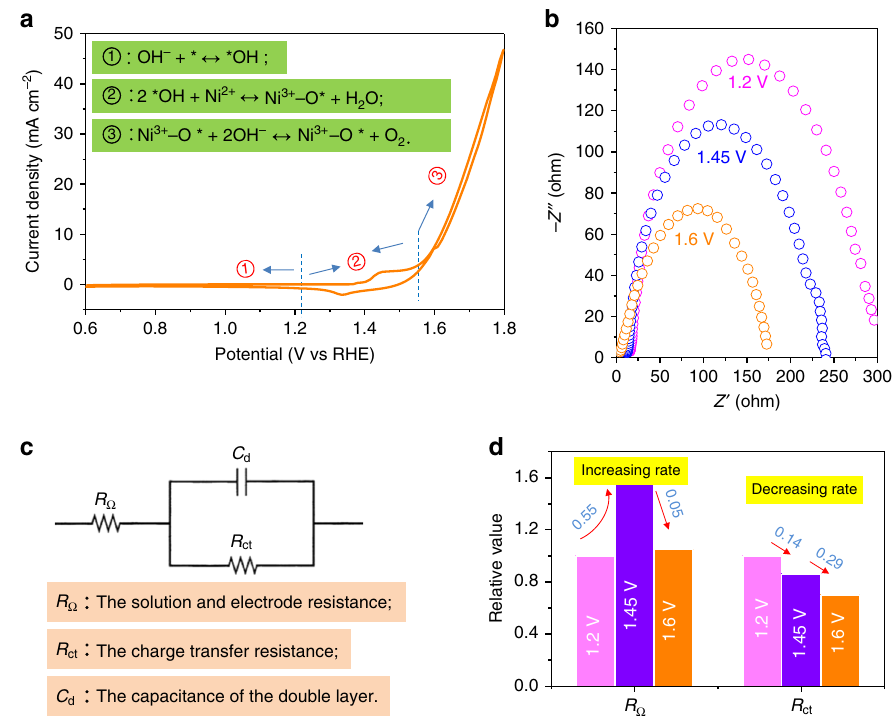
Fig. 1 Electrochemical analysis of Ni(OH) 2 for OER processes. a Cyclic voltammetry (CV) for Ni(OH) 2 at the potential range of 0.6 – 1.8 V; b Nyquist plots of Ni(OH) 2 under the three potentials of 1.2, 1.45, and 1.6 V. c Equivalent electric circuit for the EIS plots fi tting. d The change rate of the fi tted resistance values in Supplementary Table 1. The corresponding increasing and decreasing rates are for R Ω and R ct , respectively. The CV and EIS were measured in a 1 M KOH solution. Note that the proposed reaction pathways in ( a ) are not chemically